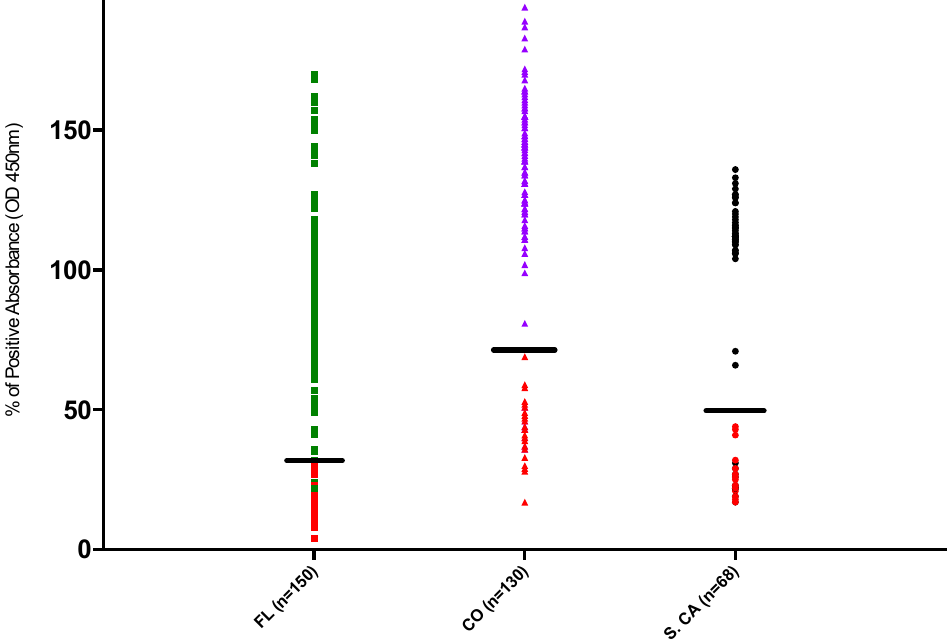
Figure 2. Seropositive OD values were well distinguished from samples classified as seronegative. The sample points in red were negative; the sample points in green, purple or black were classified as positive for their respective locations. All Colorado and all but one Southern California sample fell into positive absorbance ranges that were clearly segregated (noted with black lines) from samples classified as negative (<70% for CO, <50% for S.CA). 112 of 119 Florida samples classified as seropositive were at least 49% of positive control OD values, with only two positive samples <30% (noted with black line).